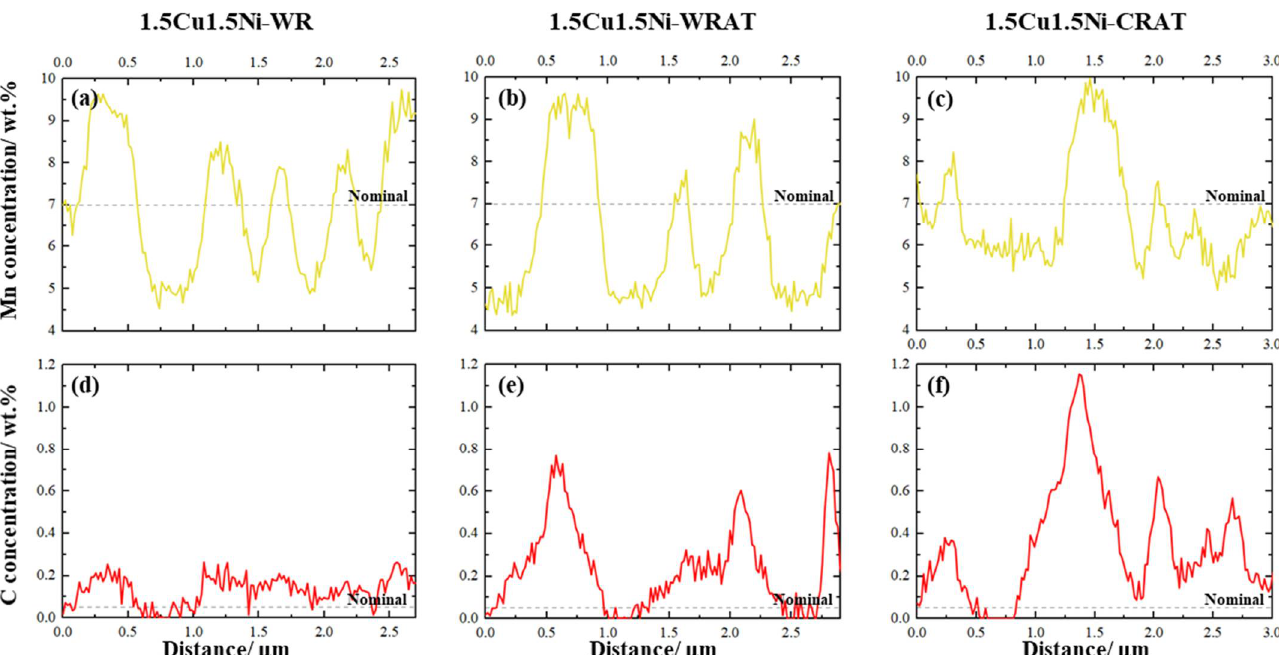
Figure 9. Elemental distribution analysis in different thermomechanical heat-treated samples of 1.5Cu1.5Ni by means of EPMA line scans across austenite and ferrite grains. ( a – c ) Mn concentration profiles, and ( d – f ) C concentration profiles in WR, WRAT and CRAT states, respectively.